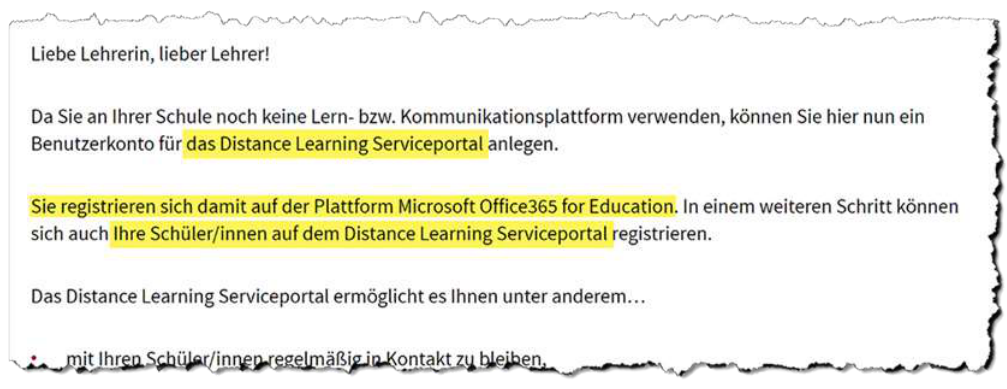
Step 2 of the registration (Source: eEducation Austria, 2020a)